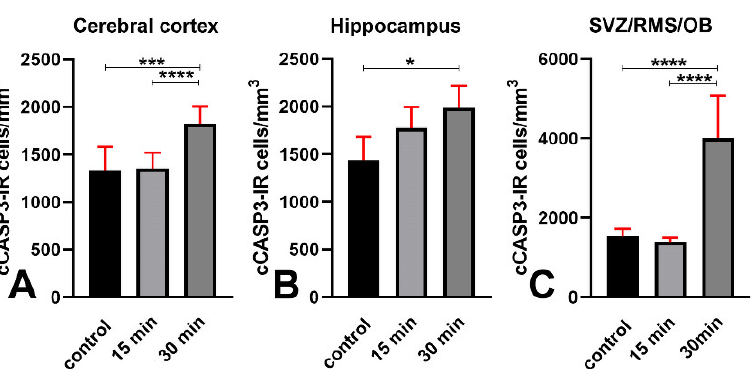
Figure 8. Volumetric density of cCASP3 immunoreactive cells in the cerebral cortex ( A ), hippocam- pus ( B ), and SVZ/RMS/OB ( C ) of control and irradiated mice. Data are grouped from two different sets of cCASP3+ γ H2AX double-labeling experiments with the Abcam and Upstate anti- γ H2AX antibodies after check that cCASP3 immunostaining was not statistically different between the two experiments. Data are expressed as mean ± 95% CI. * 0.05 > p ≥ 0.01, *** 0.001 > p ≥ 0.0001, **** p < 0.0001. Bars are 95% CI. See Appendix G for numerical data of statistics.